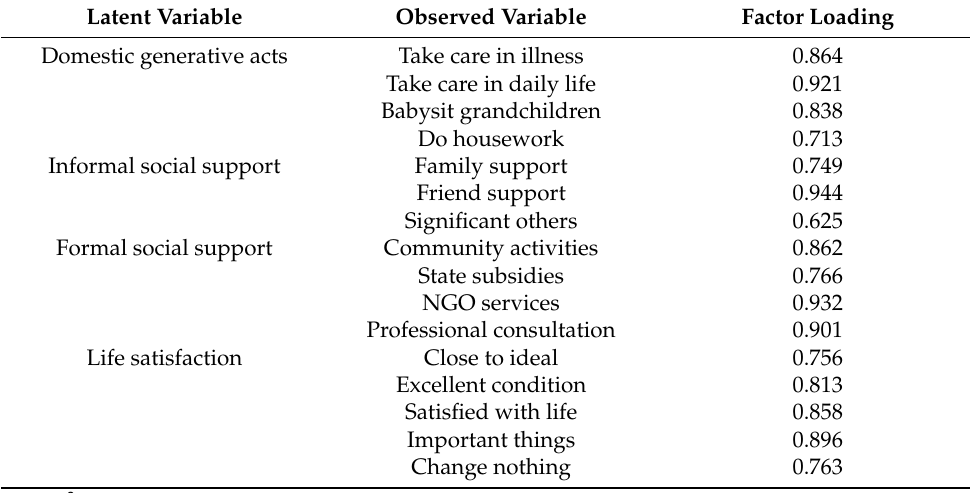
Table 4. Results of the measurement